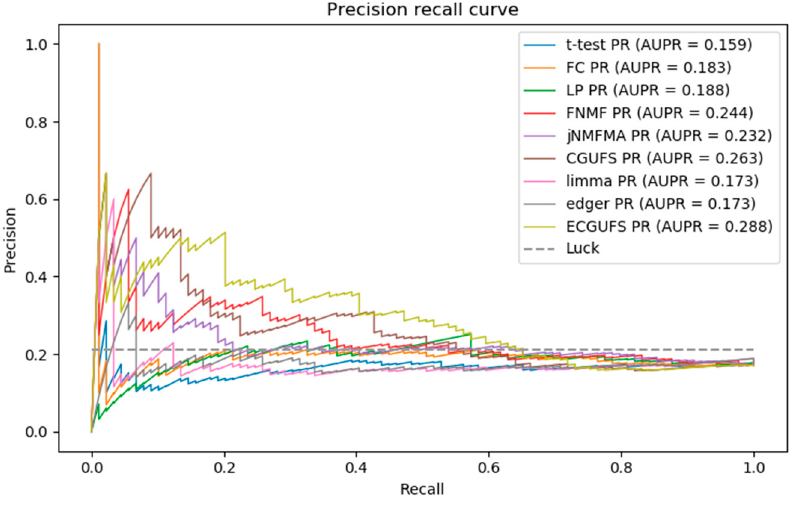
Figure 3. PR curves of the t -test, FC, LP, FNMF, jNMFMA, CGUFS, limma, edgeR, and ECGUFS prediction results.